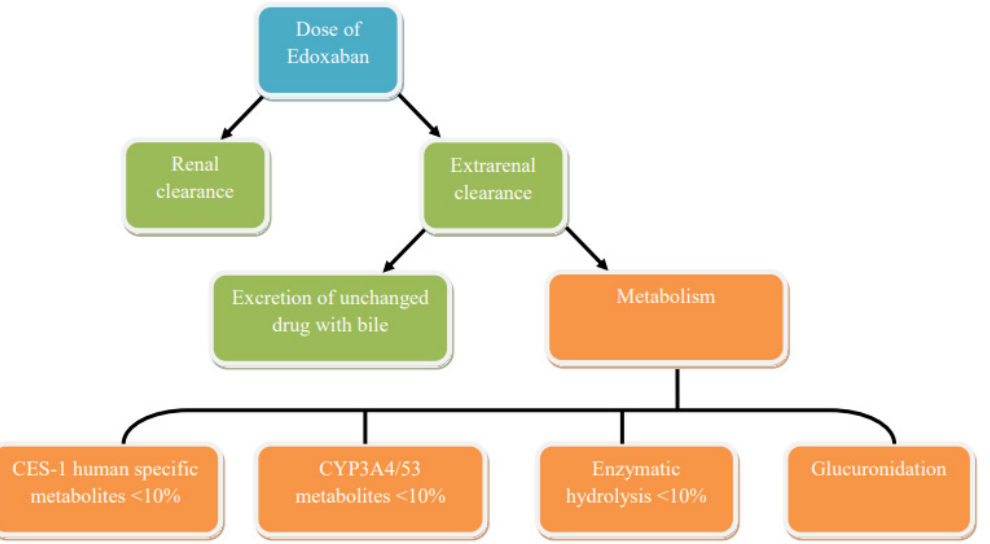
Figure 4. Chart of pathways for the elimination of edoxaban in adults .